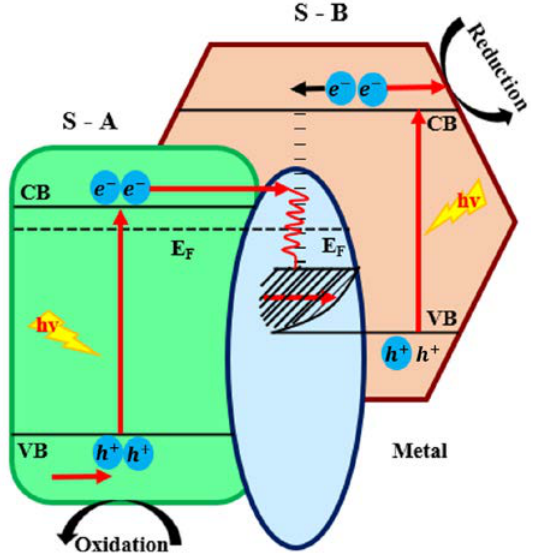
Figure 22. Schematic illustration of a typical multi-component heterojunction system.